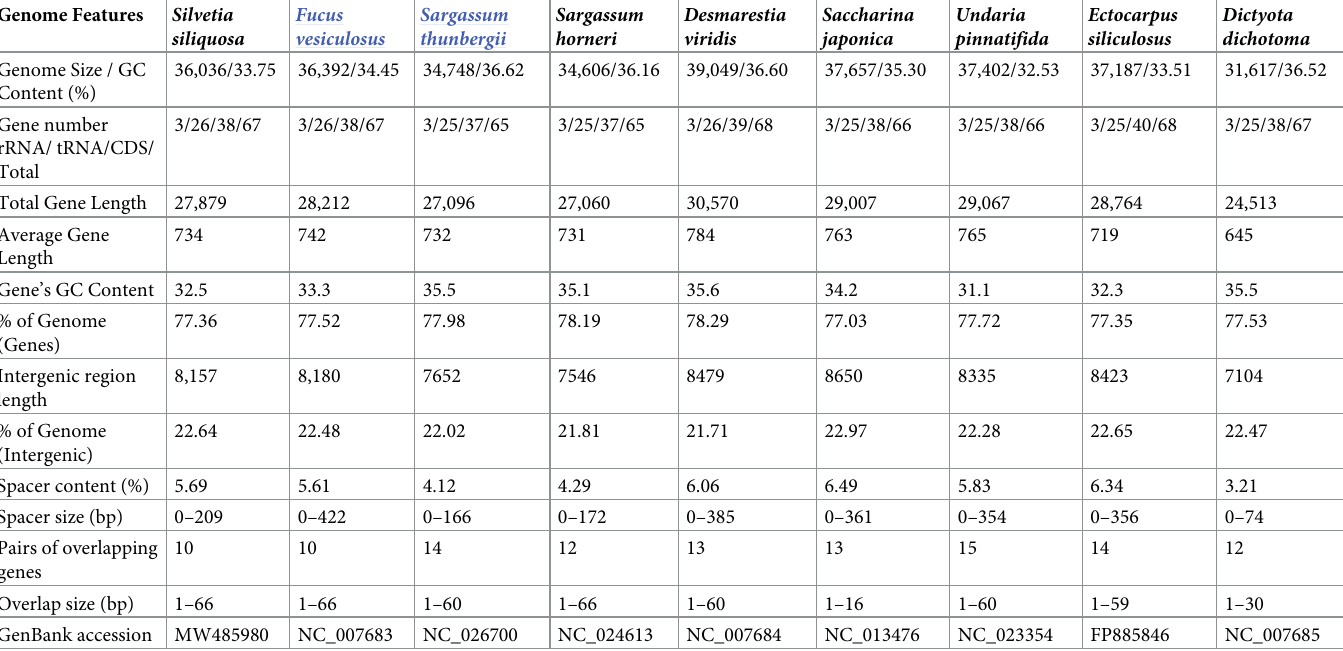
Table 1. General features of mitochondrial genomes in